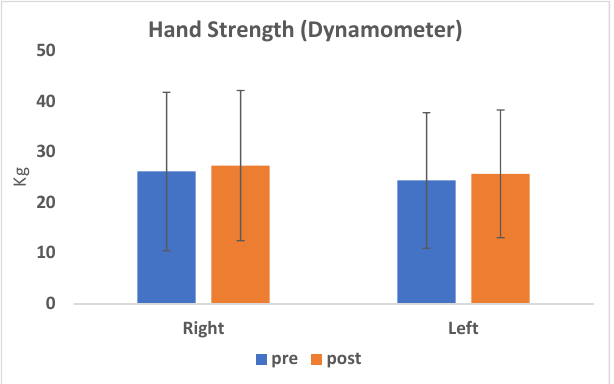
Figure 5. The average values of hand strength corresponding to the pre-surgery evaluation are shown in blue, whereas the values of hand strength corresponding to the post-surgery evaluation are shown in orange, distinguishing between right and left hand.